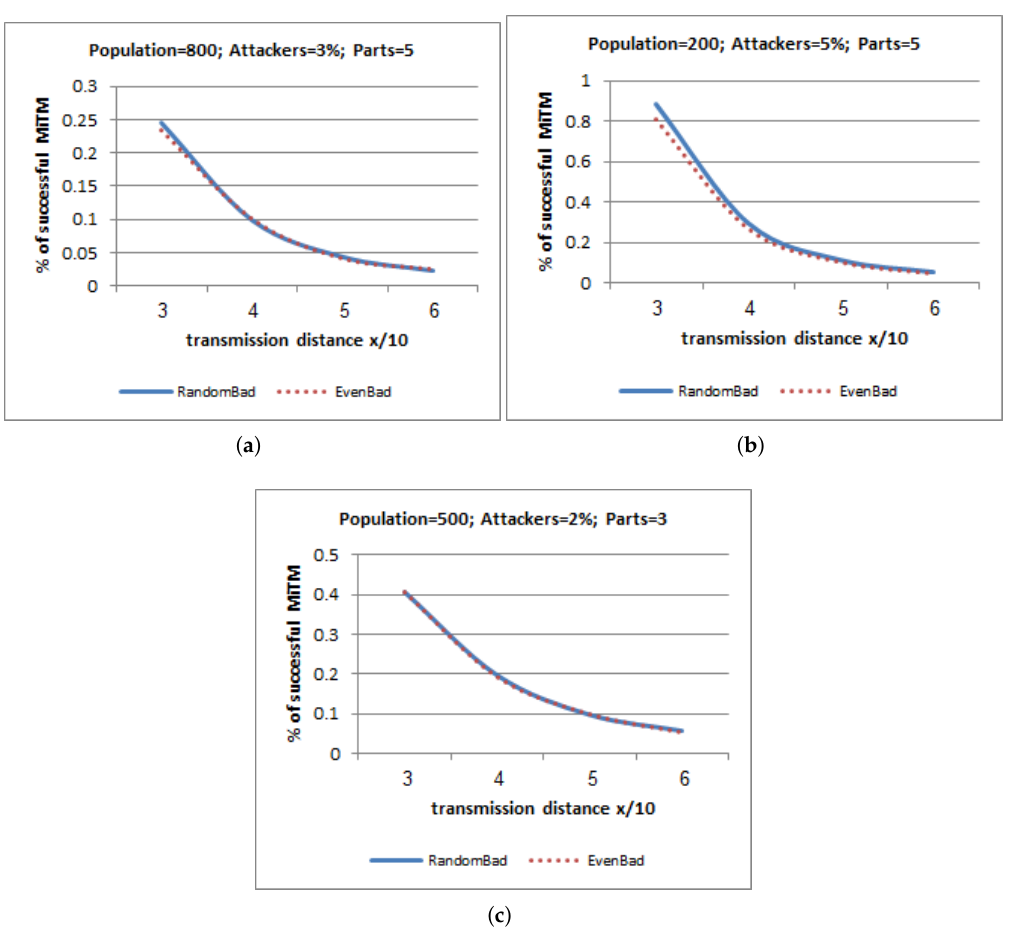
Figure 5. Fluctuating density. ( a ) Population = 800; attackers = 3%; Parts = 5. ( b ) Population = 200; attackers = 5%; Parts = 5. ( c ) Population = 500; attackers = 2%; Parts =